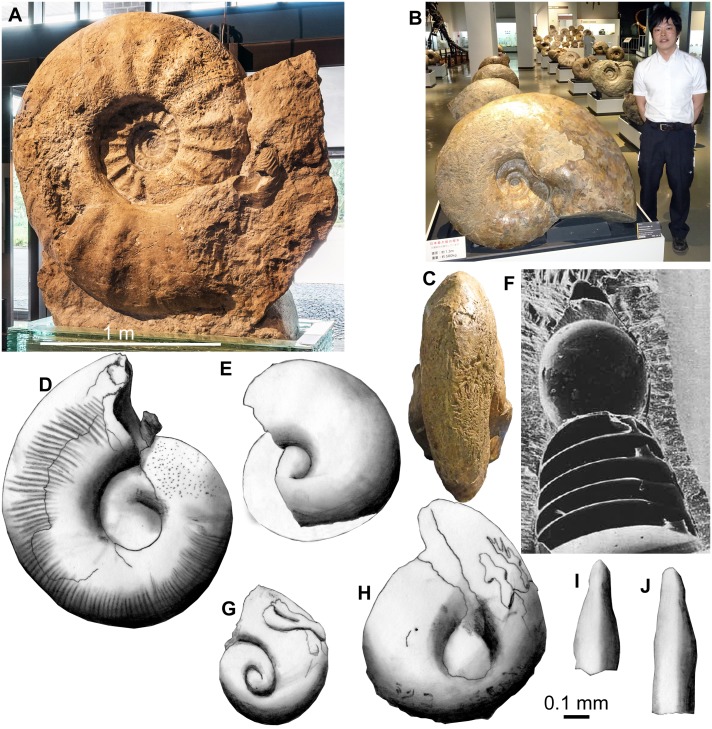
Adult ammonites (A–C), juvenile ammonites (D, E), and an embryonic belemnite (F) compared to fossil conchs of Thecosomata from the Eocene of India (G–J). 0.1 mm-scale bar applies to figures D to J.Photo in (A) courtesy C Steinweg, L Schöllmann and J-O Kriegs (all Mnster); (D and E) redrawn after Tanabe, Kulicki & Landman (2008); (F) from Bandel et al. (1984); (G to J) redrawn after Lokho & Kumar (2008). (A) Parapuzosia seppenradensis, Campanian, Seppenrade. (B) C. Pachydesmoceras sp., Campanian, Hokkaido, diameter 1.3 m, D. Aiba (Mikasa) for scale. Note the symmetrical bulges in the posterior body chamber in C. (D) juvenile conch of Scaphites whitfieldi, AMNH 44833, Turonian, USA. (E) embryonic conch of Aconeceras cf. trautscholdi, UMUT MM 29439–4, Aptian, Russia. (F) embryonic conch of Hibolithes sp., GPIT Ce 1599, Callovian, Lithuania. (G) to (J), Upper Disang Formation, Phek District, Nagaland. (G, H) Limacinidae spp. (I, J) Creseidae spp.